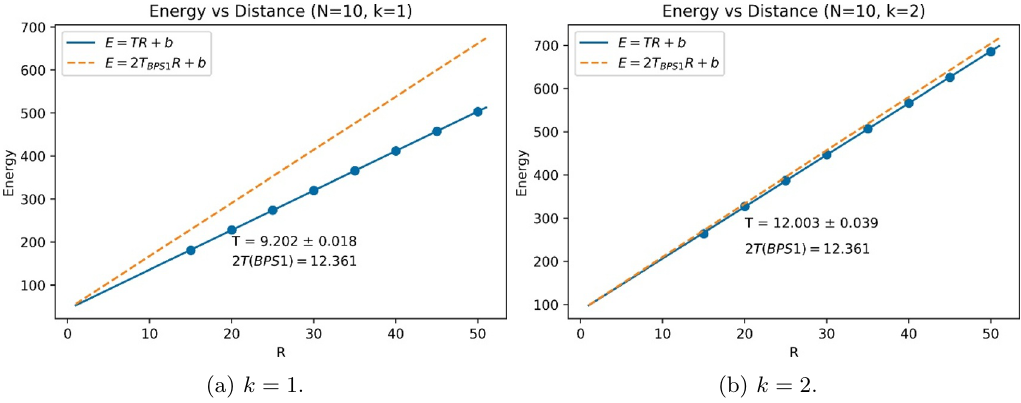
Figure 11. Linear relation between energy ˜ E and quark separation R for N = 10 and (a) k = 1 and (b) k = 2 . The string tension is the fitted slope. For comparison, twice the BPS 1-wall tension is also plotted with a dashed